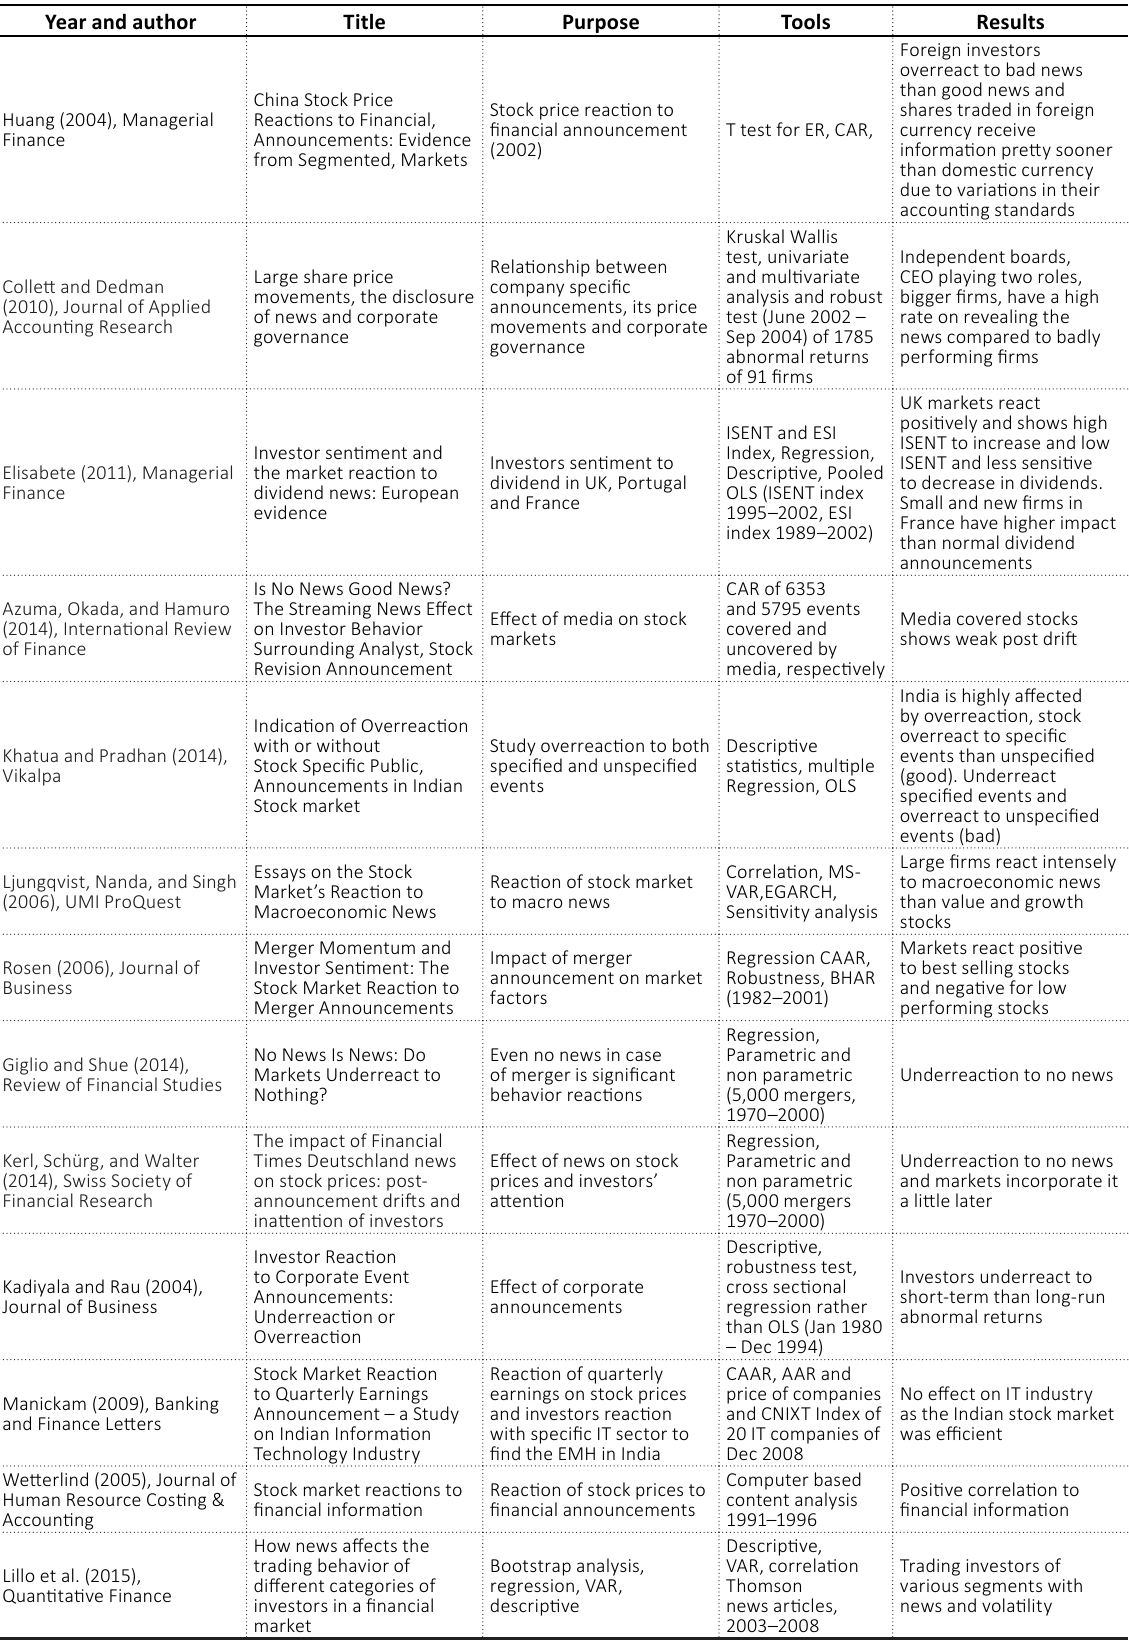
Table A1 (cont.). Empirical literature and tools used on investors reaction to news in various